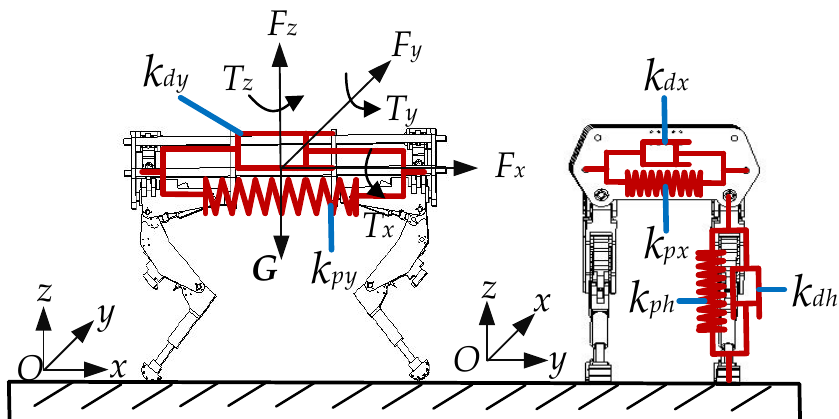
Figure 4. Centroid control model of hydraulic quadruped robot.